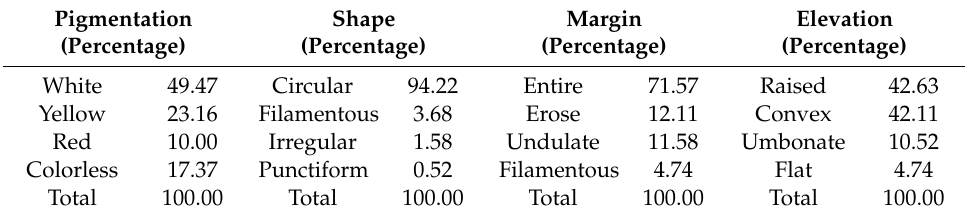
Table 2. Percentage of the morphology of the isolated bacteria from the mangrove wetland soil.